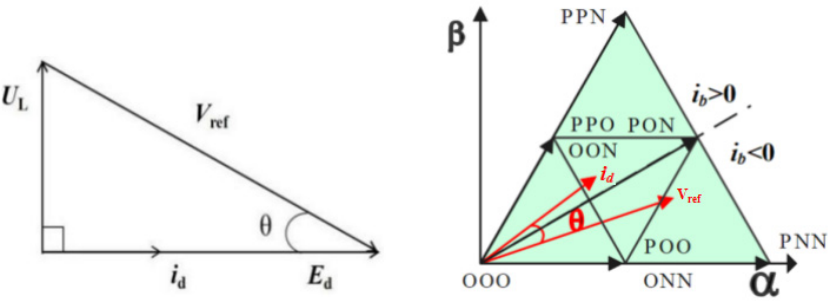
Figure 4. Vector relation of input voltage and current and vector diagram of large sector I space.